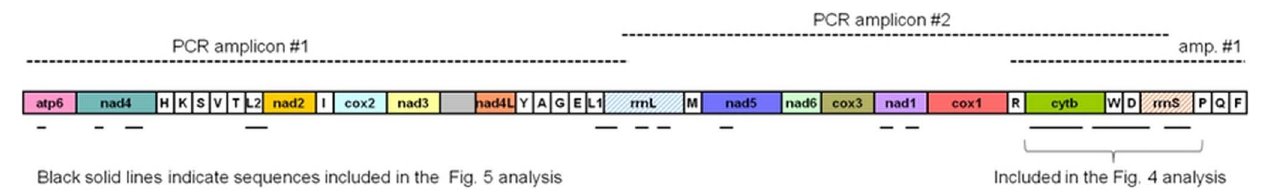
Figure 1. Schematic of loci of mitochondrial DNA analyzed. Rectangles with solid colors show mtDNA protein-coding genes, dashed rectangles show ribosomal RNA genes, and white rectangles show tRNA genes (single-letter abbreviations for associated amino acids). The dashed lines on top indicate the regions amplified in the two long PCRs used to generate templates for Illumina sequencing. Information about regions used for phylogenetic analyses is provided at the